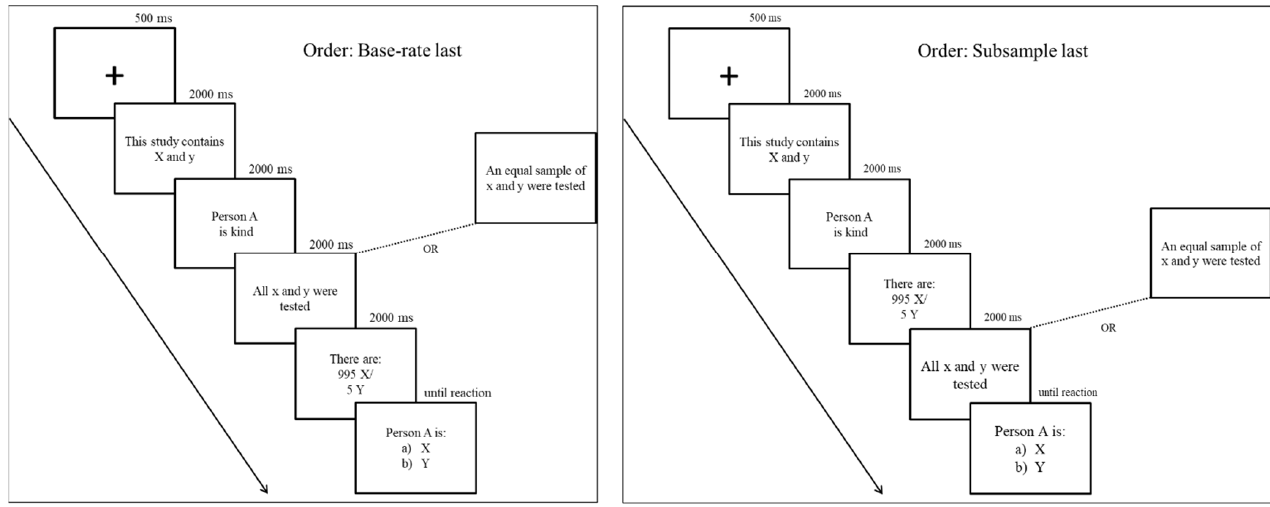
Figure 4. Procedure for rapid-response base-rate task (Experiment 3).